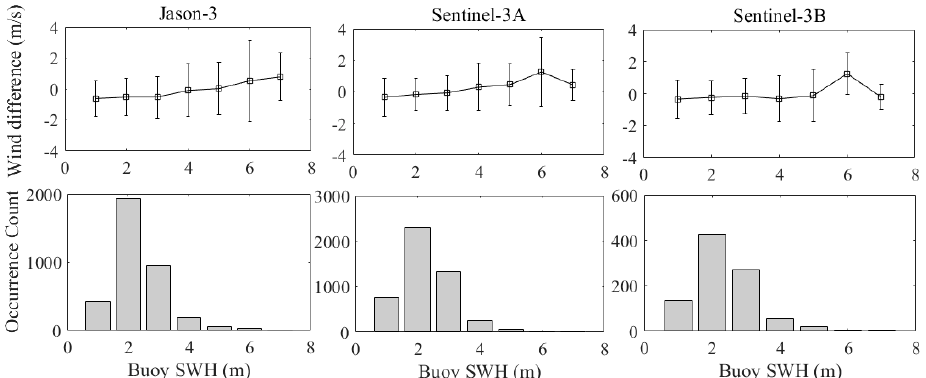
Figure 6. Dependence of statistical parameters of WS differences between the Jason-3, Sentinel-3A, Sentinel-3B altimeters and the moored buoys on the buoy-derived SWH.